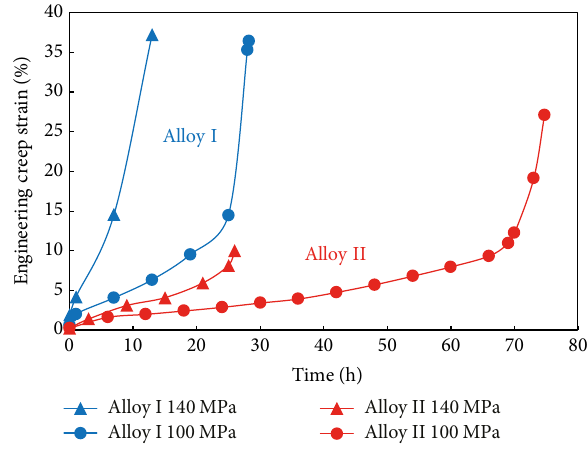
Figure 6: Creep curves at 800 ∘ C and constant load of 100 ( e ) and 140 ( 󳵳 ) MPa for alloys I and